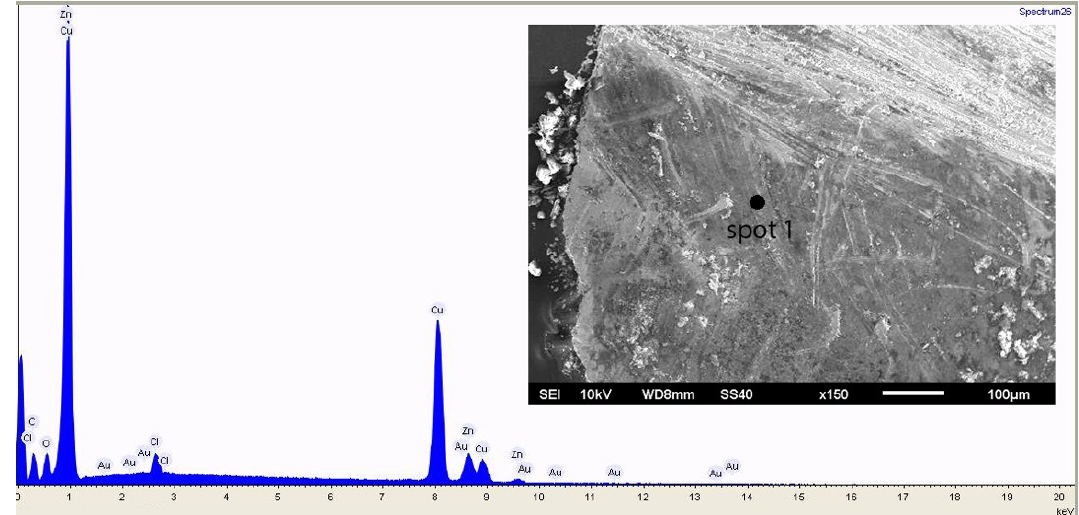
Figure 3. SEM image of the sample D1 and EDX spectrum of spot 1 in sample D1. Cu, Zn, and Au were identified.